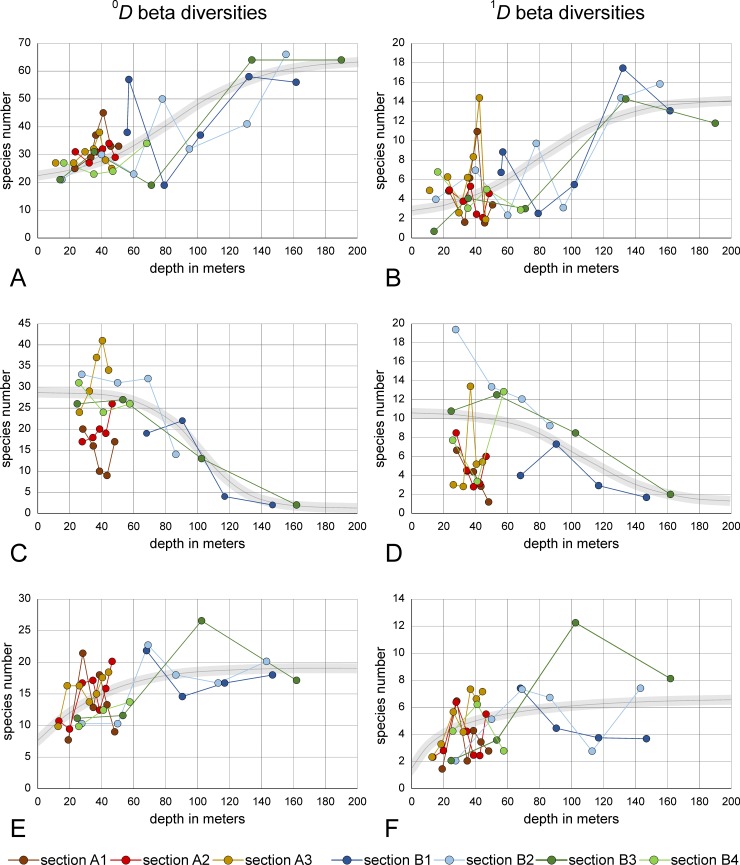
Beta diversities along transects determined by Hill numbers 0D (species number) and 1D (dominant species).A, B. Comparison between LAs and DAs of transect sites. C, D. Comparison between LAs of succeeding sites along transects. E, F. comparison between DAs of succeeding sites along transects. Grey lines: fit by logistic functions.